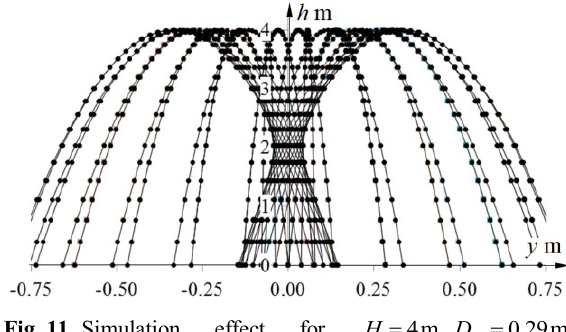
Fig. 11 . Simulation